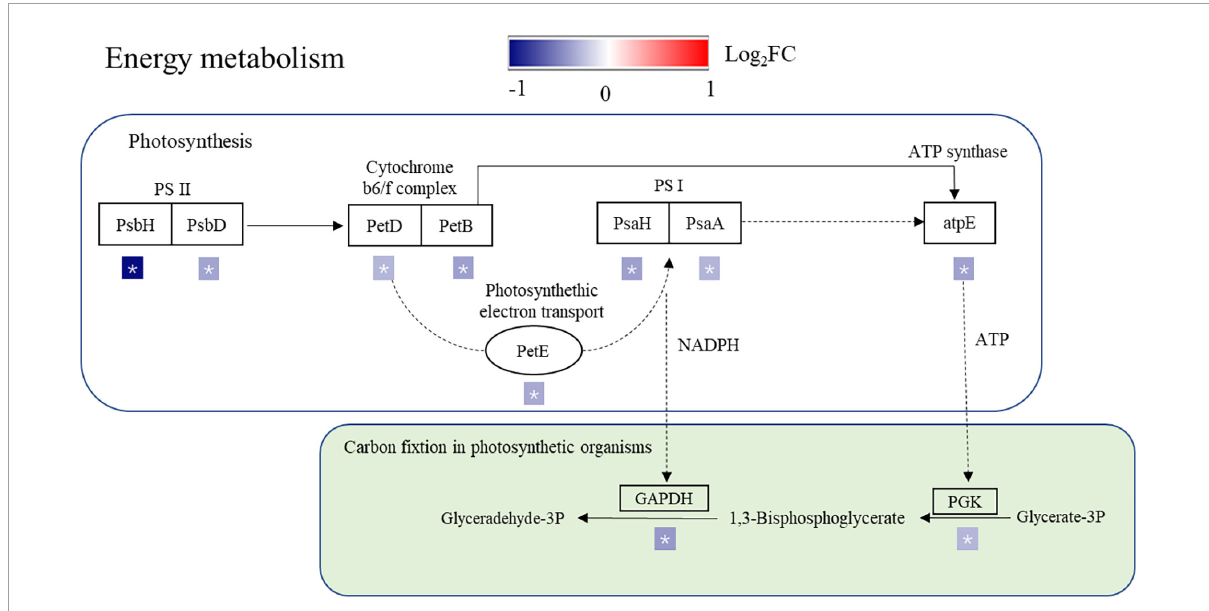
FIGURE6 Differentially expressed proteins (DEPs) associated with the photosynthesis pathway and carbon fixation in the photosynthetic organism pathway. PsbH, PSII reaction center protein H; PsbD, PSII D2 protein; PetD, cytochrome b6-f complex subunit 4; PetB, cytochrome b6; PetE, plastocyanin; PsaH, photosystem I reaction center subunit VI; PsaA, PSI P700 chlorophyll a apoprotein A1; atpE, ATP synthase epsilon chain; PGK, phosphoglycerate kinase; GAPDH, glyceraldehyde-3-phosphate dehydrogenase; FBA1, fructose-bisphosphate aldolase. The different protein changes are represented by log 2 (FC). Red and blue indicate upregulated and downregulated proteins, respectively, * indicates a significant